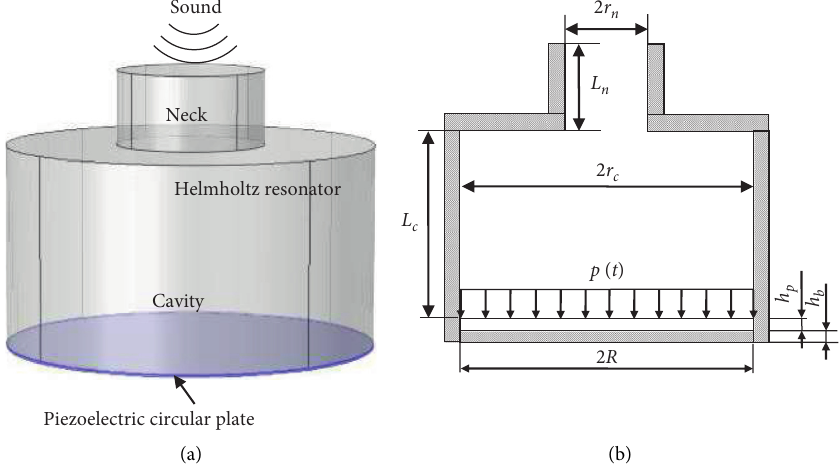
Figure 4: Design of acoustic energy harvester: (a) axonometric drawing and (b) cutaway view.